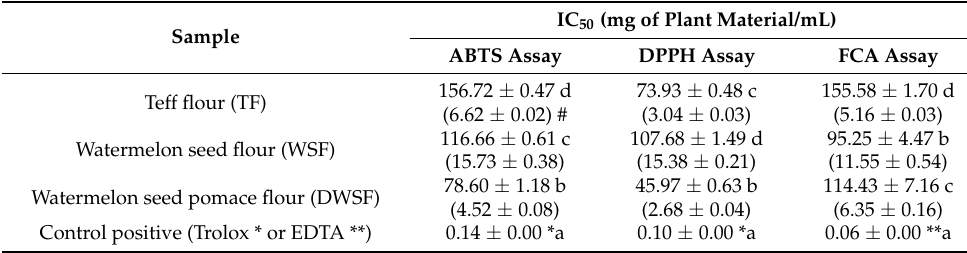
Table 5. Antiradical and metal chelating activity in vitro of aqueous methanolic extracts of teff and watermelon material using 2,2 (cid:48) -azinobis-3-ethylbenzthiazoline-6-sulphonic acid (ABTS) and 2,2-diphenyl-1-picrylhydrazyl (DPPH) radical and ferrous ion chelating (FCA) assays (mean ± SD). IC 50 (mg of Plant Material/mL) Sample ABTS Assay DPPH Assay Teff flour